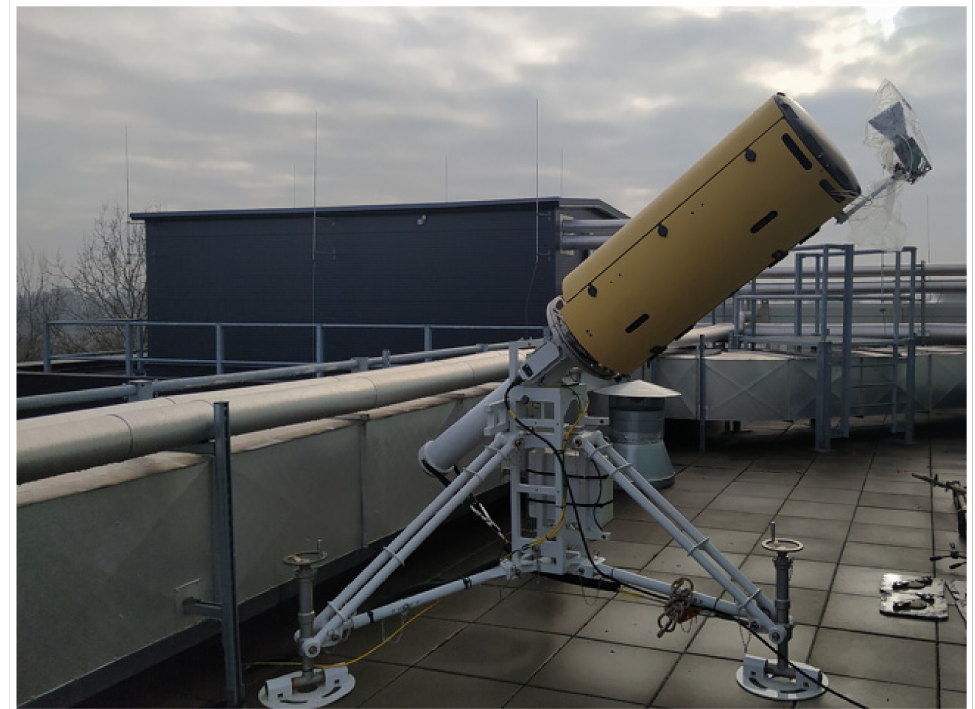
Figure 1. ESM sensor “C” (Center) with external sector antenna IZ151 which has been repeatedly and successfully used in order to intercept a SAR emitter in LEO orbits [6].